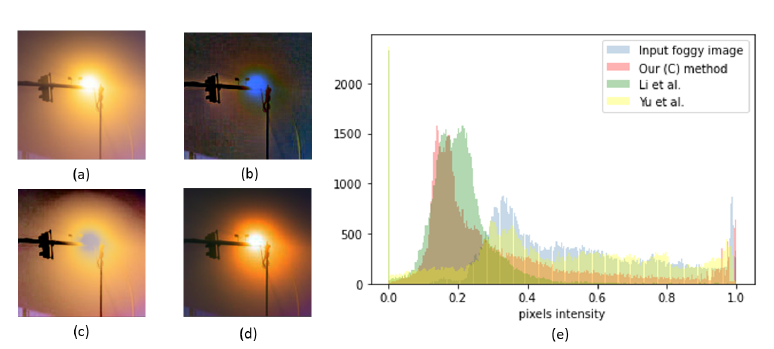
Figure 18. Comparison on a glow patch: ( a ) foggy image, ( b ) Li et al. [31], ( c ) Yu et al. [42], ( d ) restored image with the color version of our algorithm, ( e ) histogram of the intensity of each glow patch (glow images are adapted with permission from ref. [35]. Copyright 2021 Mark Broyer).